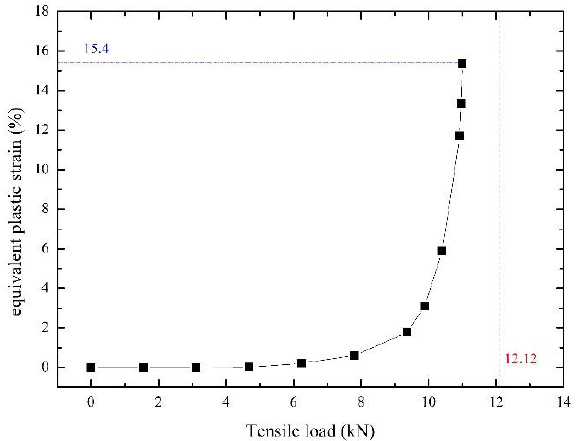
Figure 21. The variation of equivalent plastic strain with tensile load.